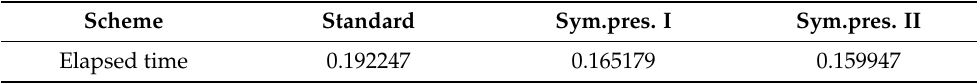
Table 2. Elapsed time comparison of the